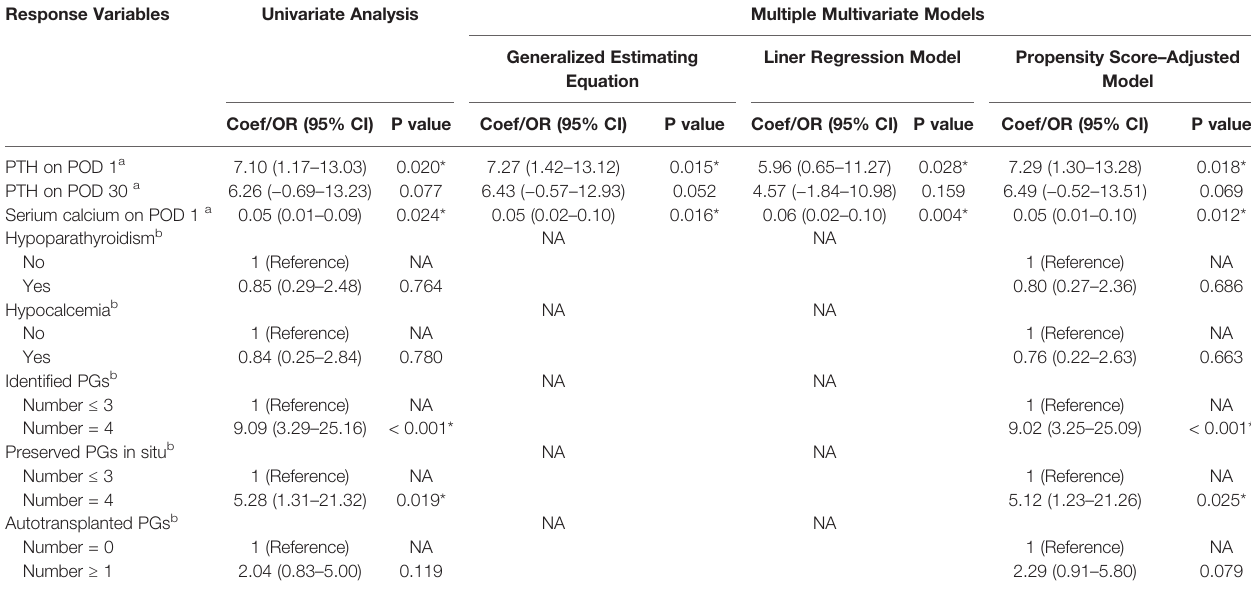
TABLE 3 | Coef fi cients or odd ratios of the use of ICGA vs. nonuse in diferent models with different surgery outcomes as response variables.